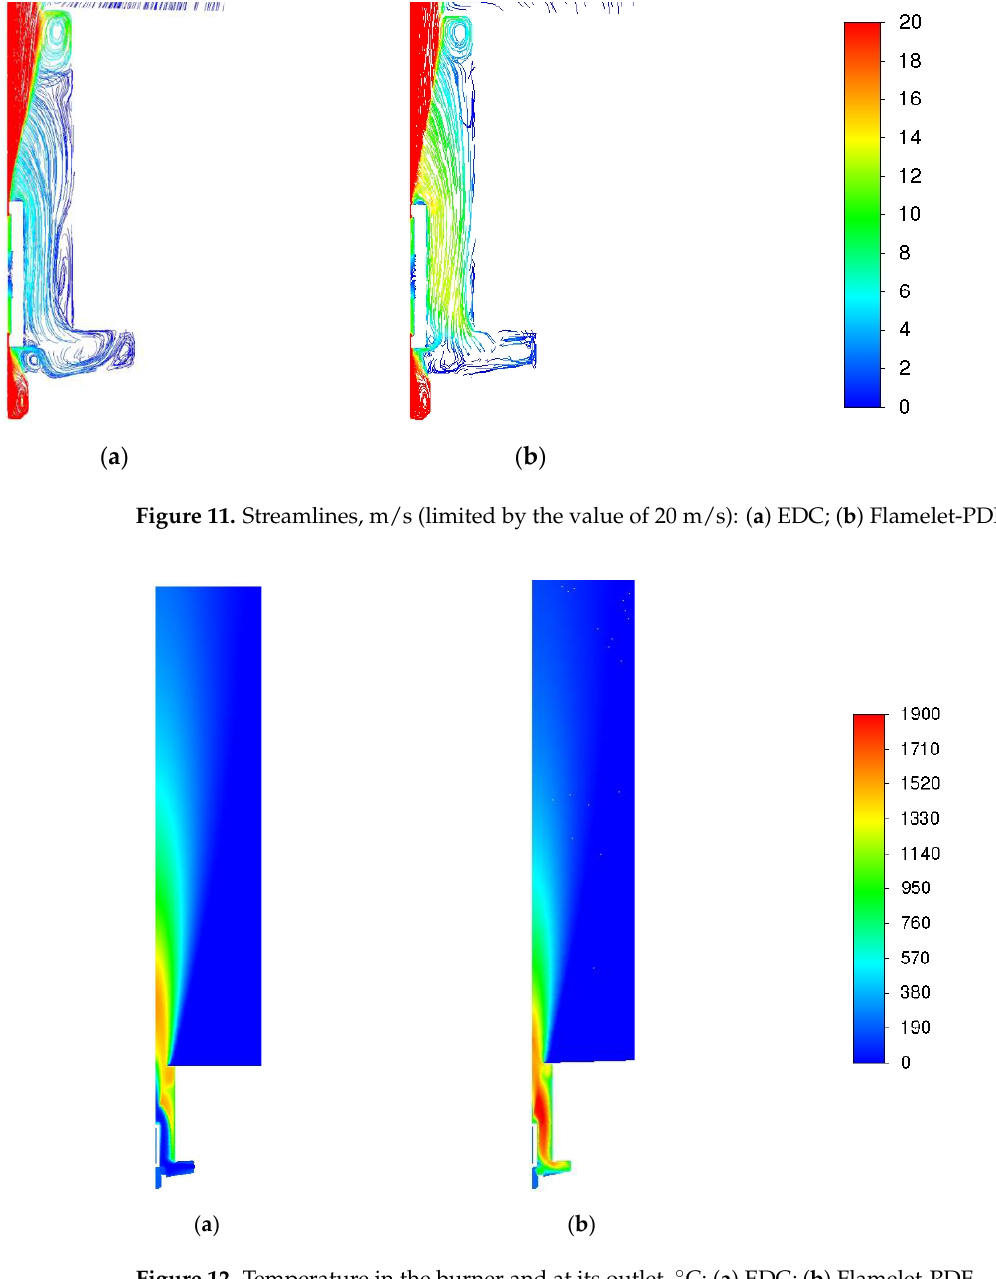
Figure 12. Temperature in the burner and at its outlet, ◦ C: ( a ) EDC; ( b )